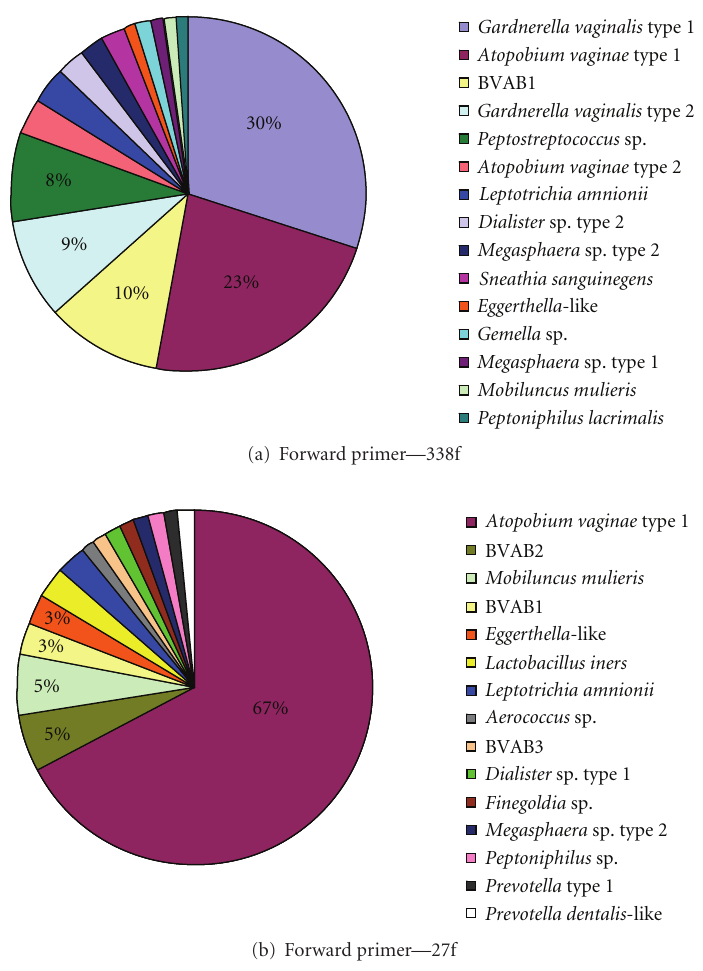
Figure 2: Comparison of vaginal bacterial species detected by broad range 16S rRNA gene PCR using two di ff erent forward primers and the same reverse primer in one sample. The pie charts show the percentages of clones in each library corresponding to specific bacterial 16S rRNA gene sequences obtained using broad range PCR followed by cloning and sequencing in a vaginal sample from a subject diagnosed with bacterial vaginosis. Data obtained using the 338f (a) primer shows a balanced representation of clones while the data obtained using the 27f (b) primer is skewed toward Atopobium vaginae . Note the absence of Gardnerella vaginalis clones in the clone library created with the 27f primer. BVAB denotes bacterial vaginosis associated